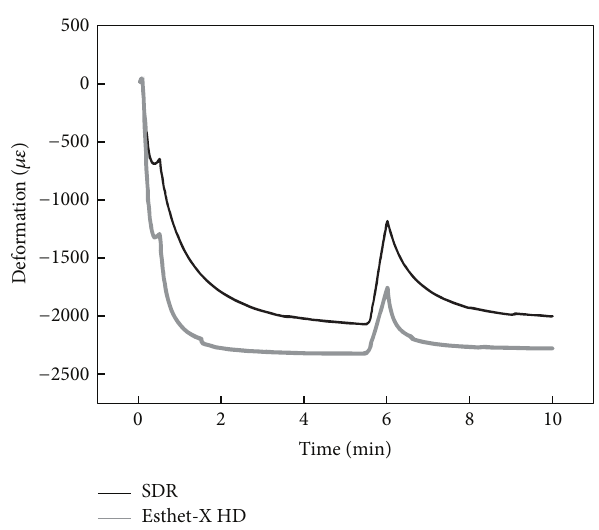
Figure 5: Average cuspal deformation induced by SDR (cid:3) and Esthet ∙ X (cid:2) HD resins during the 10 minutes of real-time